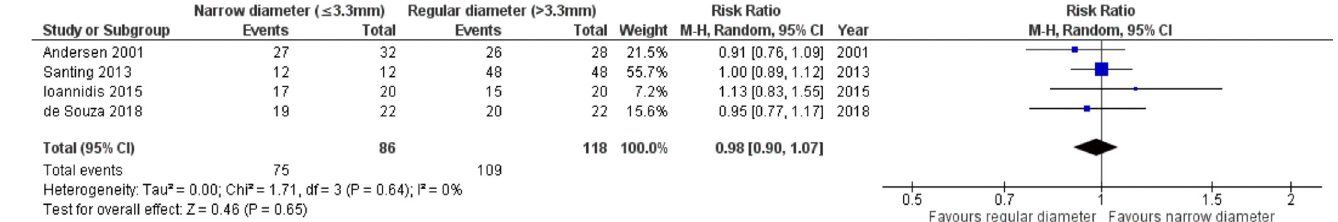
Fig 2. Forest plot of all intervention studies comparing the longevity of narrow and standard implants.